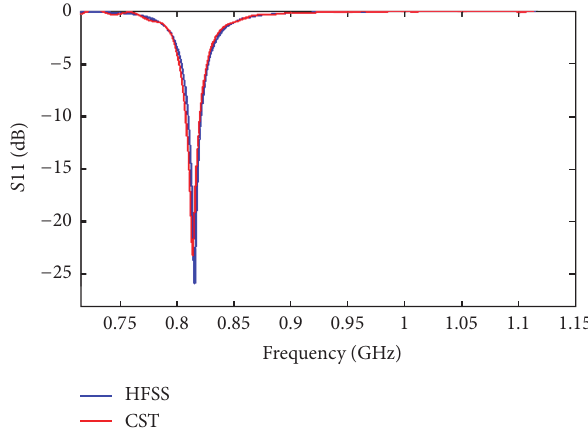
Figure 4: Structure of the 3D spherical antenna (Figure 2) with T- match. Figure 5: Return loss 𝑆11 of the 3D spherical antenna (Figure